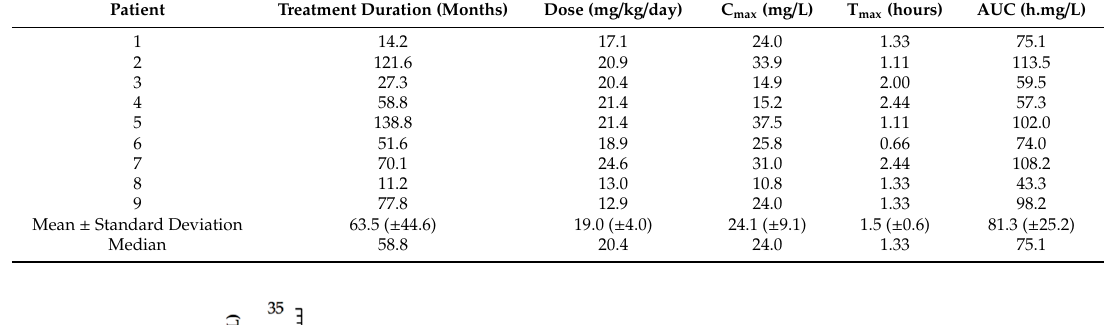
Table 3. Pharmacokinetics parameters of the nine children on HU.